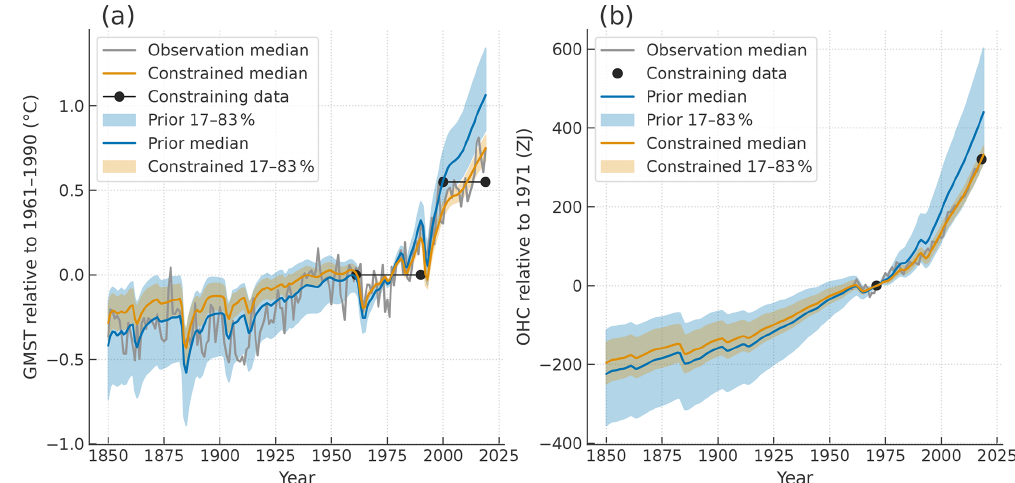
Figure 10. (a) Historical global mean surface temperature (GMST) relative to 1961–1990 and (b) historical ocean heat content (OHC) relative to 1971 in the period 1850–2019 compared with observation data from HadCRUT4.6.0.0 for GMST and von Schuckmann et al. (2020) for OHC. The black dots indicate the levels in two different periods or years used for the observation